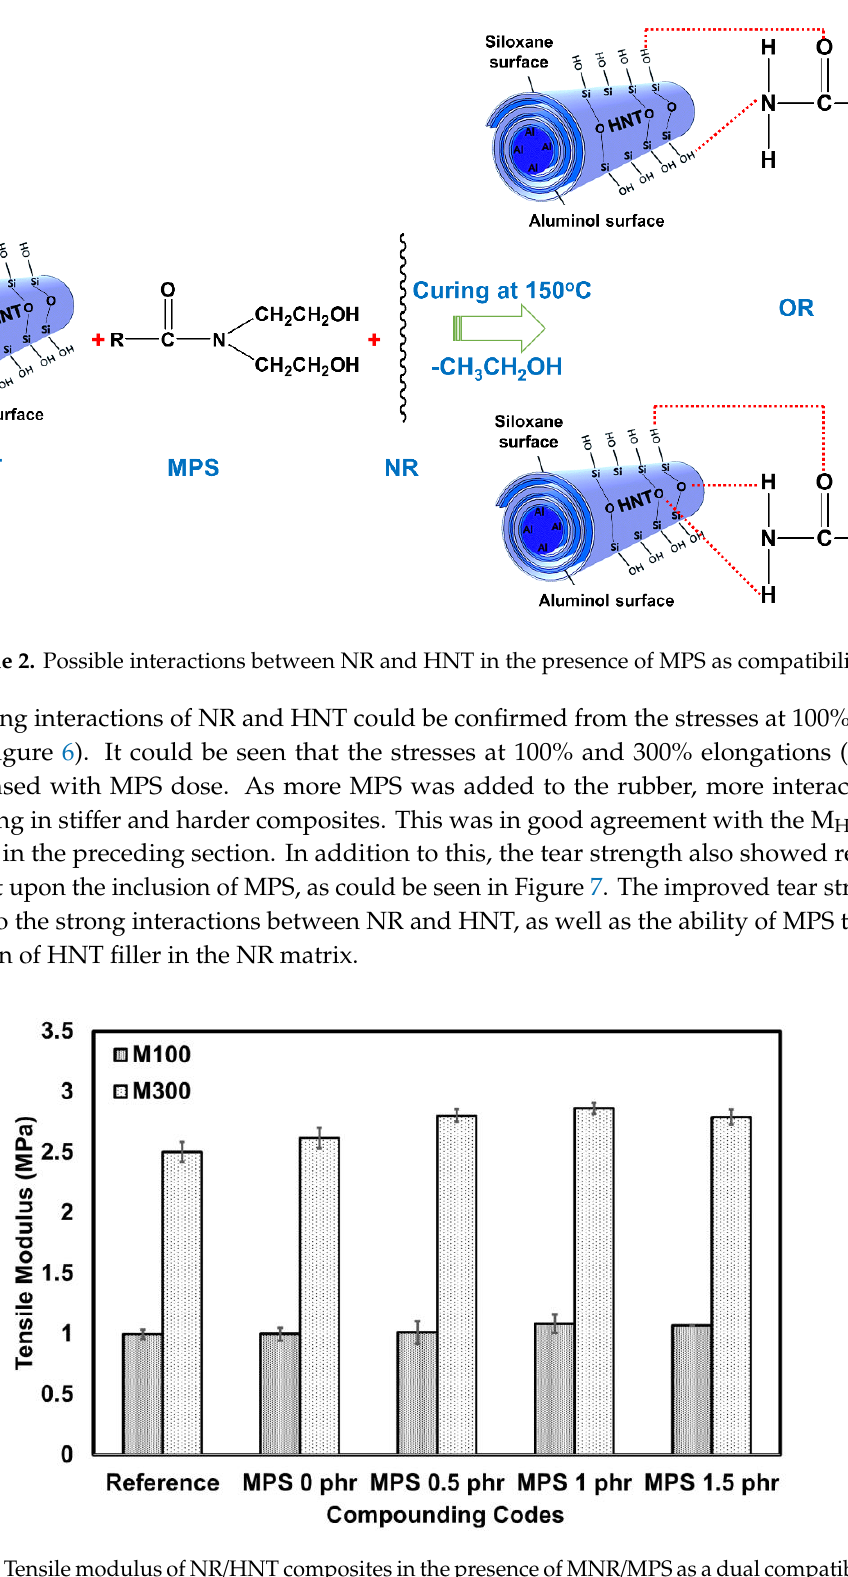
Figure 6. Tensile modulus of NR / HNT composites in the presence of MNR / MPS as a dual compatibilizer.